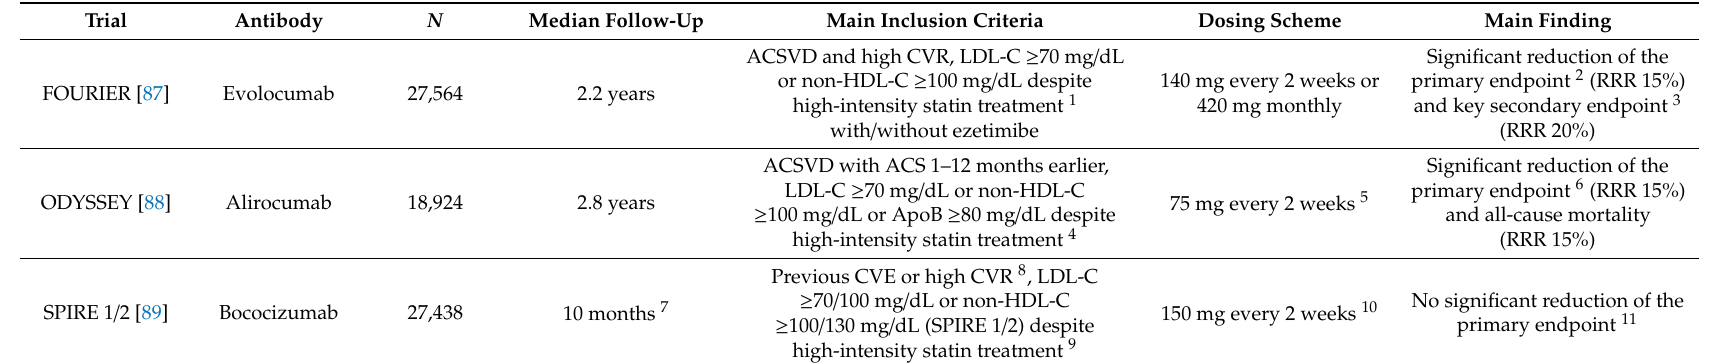
Table 1. Clinical trials testing proprotein convertase subtilisin / kexin 9 (PCSK9)